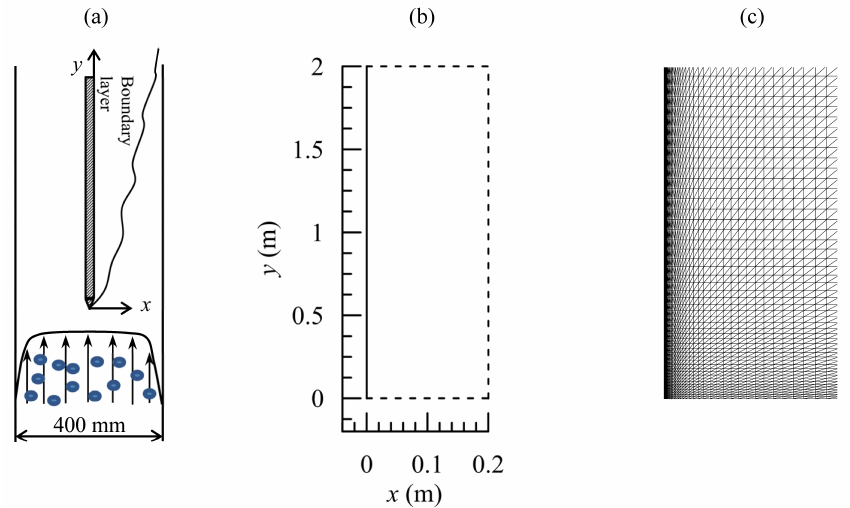
Figure 2 - Sketch of the flow configuration, simulation domain and detail of the isoP2 mesh distribution.